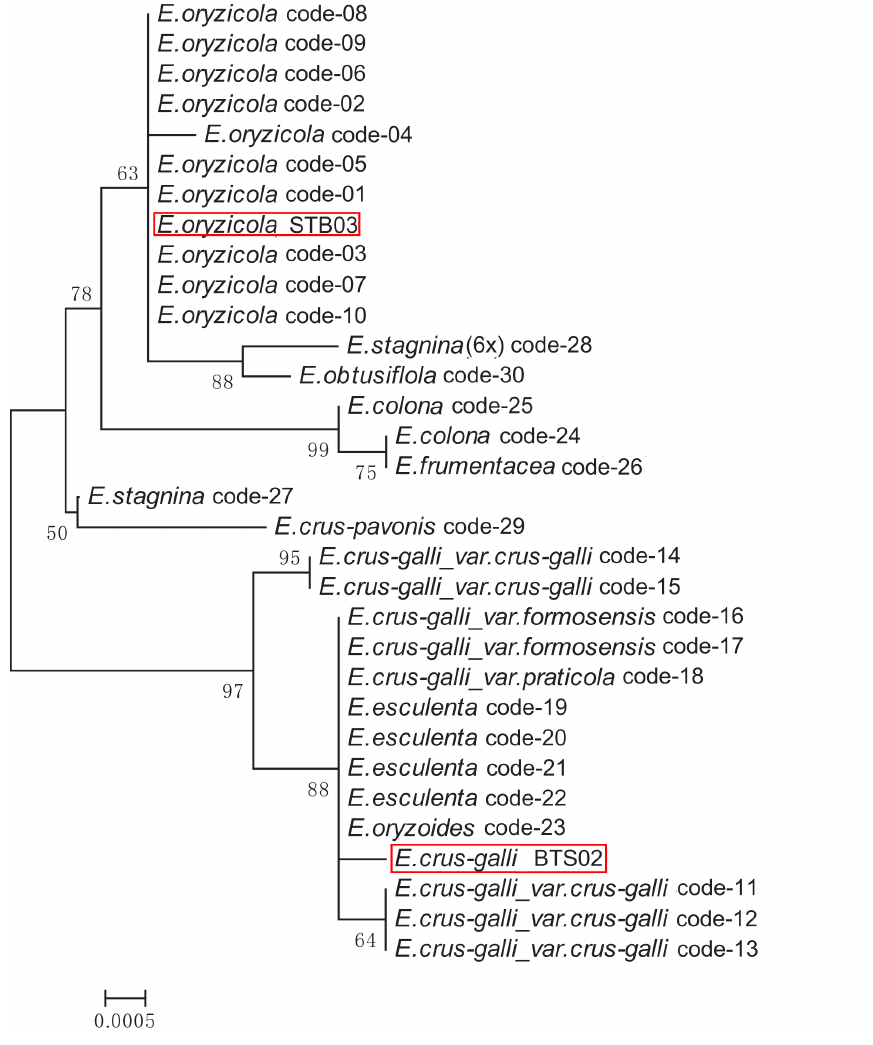
Figure 1. Phylogenetic relationships among STB03, BTS02, and 30 Echinochloa accessions based on the nucleotide sequences of trn T-L-F region of the chloroplast genome. See the study by Yamaguchi et al. (2005) for code numbers of the 30 accessions [12]. The tree was constructed using NJ method. Bootstrap values with less than 50 are not shown.